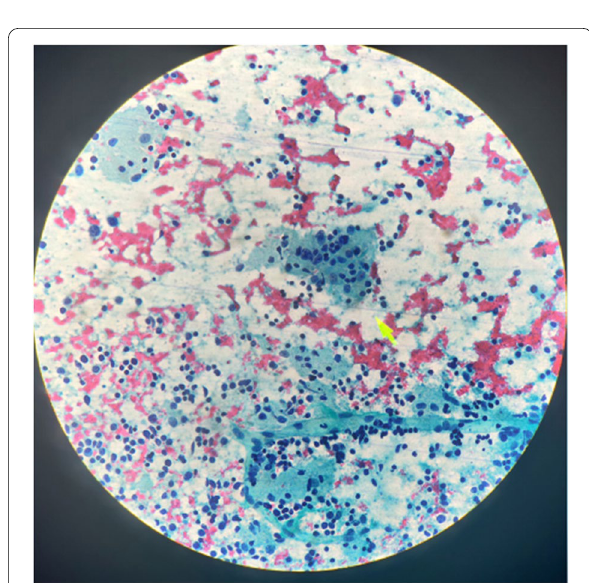
Fig. 5 Arrow mark showing emperipolesis—foamy histiocytes in emperipolesis form, there was mixed population of small and large lymphocytes with few plasma cells and